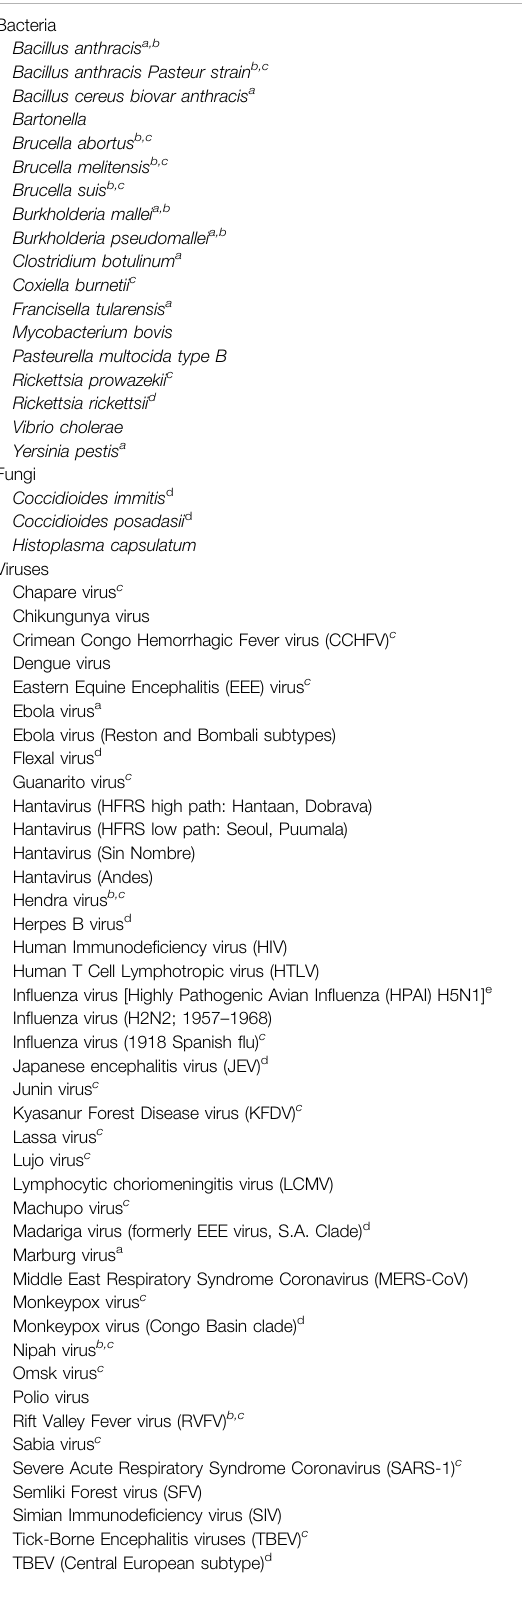
TABLE 1 | HHS Select and non-select agents evaluated in this study. Bacteria Bacillus anthracis